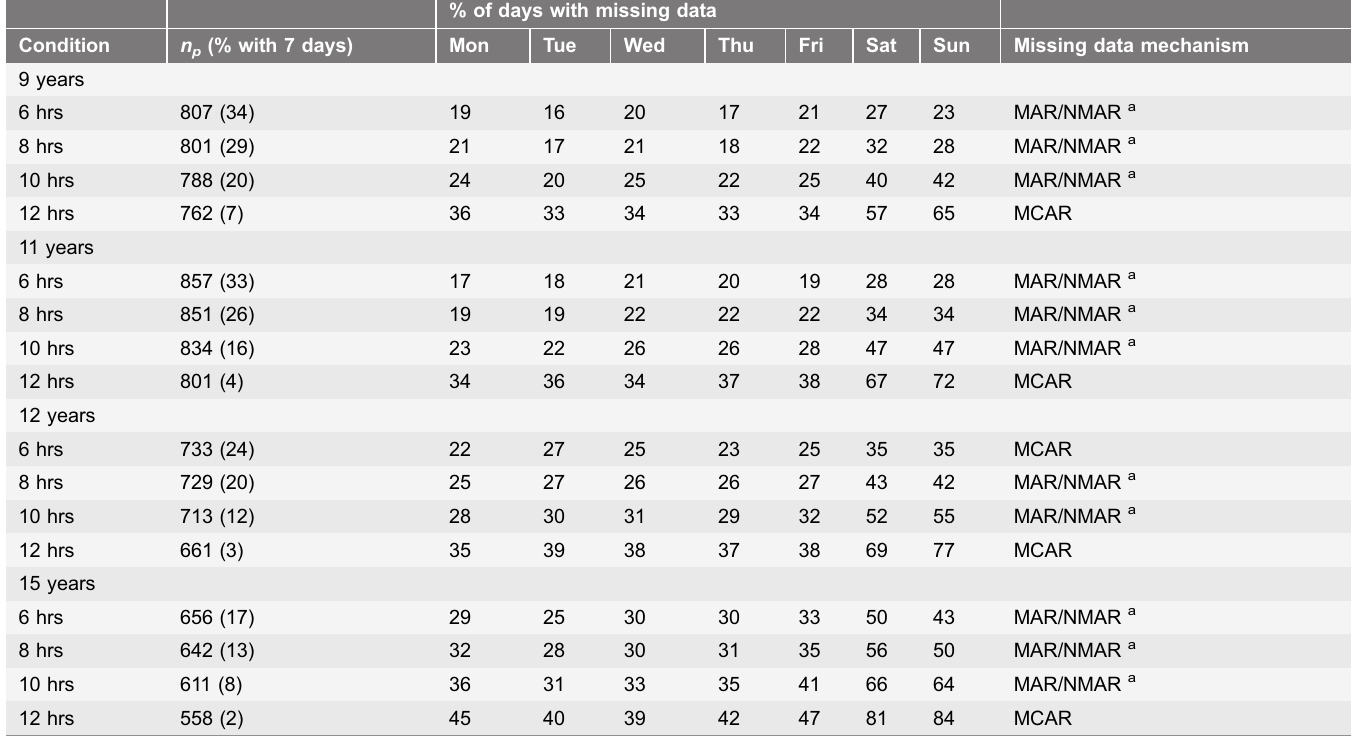
MAR, missing at random; MCAR, missing completely at random; NMAR, not missing at random; n p , number of participants. a Little’s test, p ,